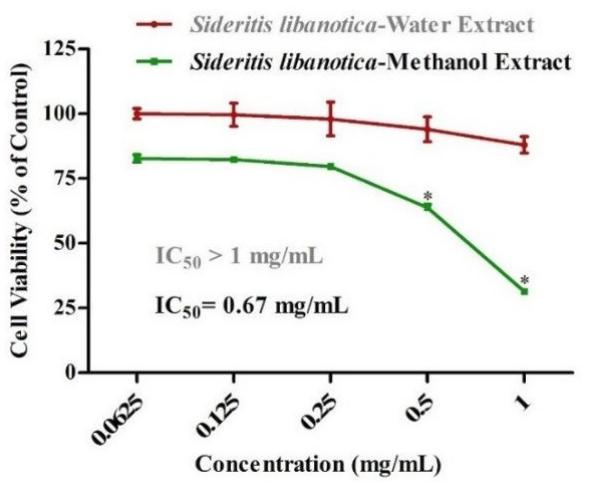
Fig. 1. Effects of the water and methanol extracts from S. libanotica on the viability of MDA-MB-231 cell line, after treatment with various concentrations (range: